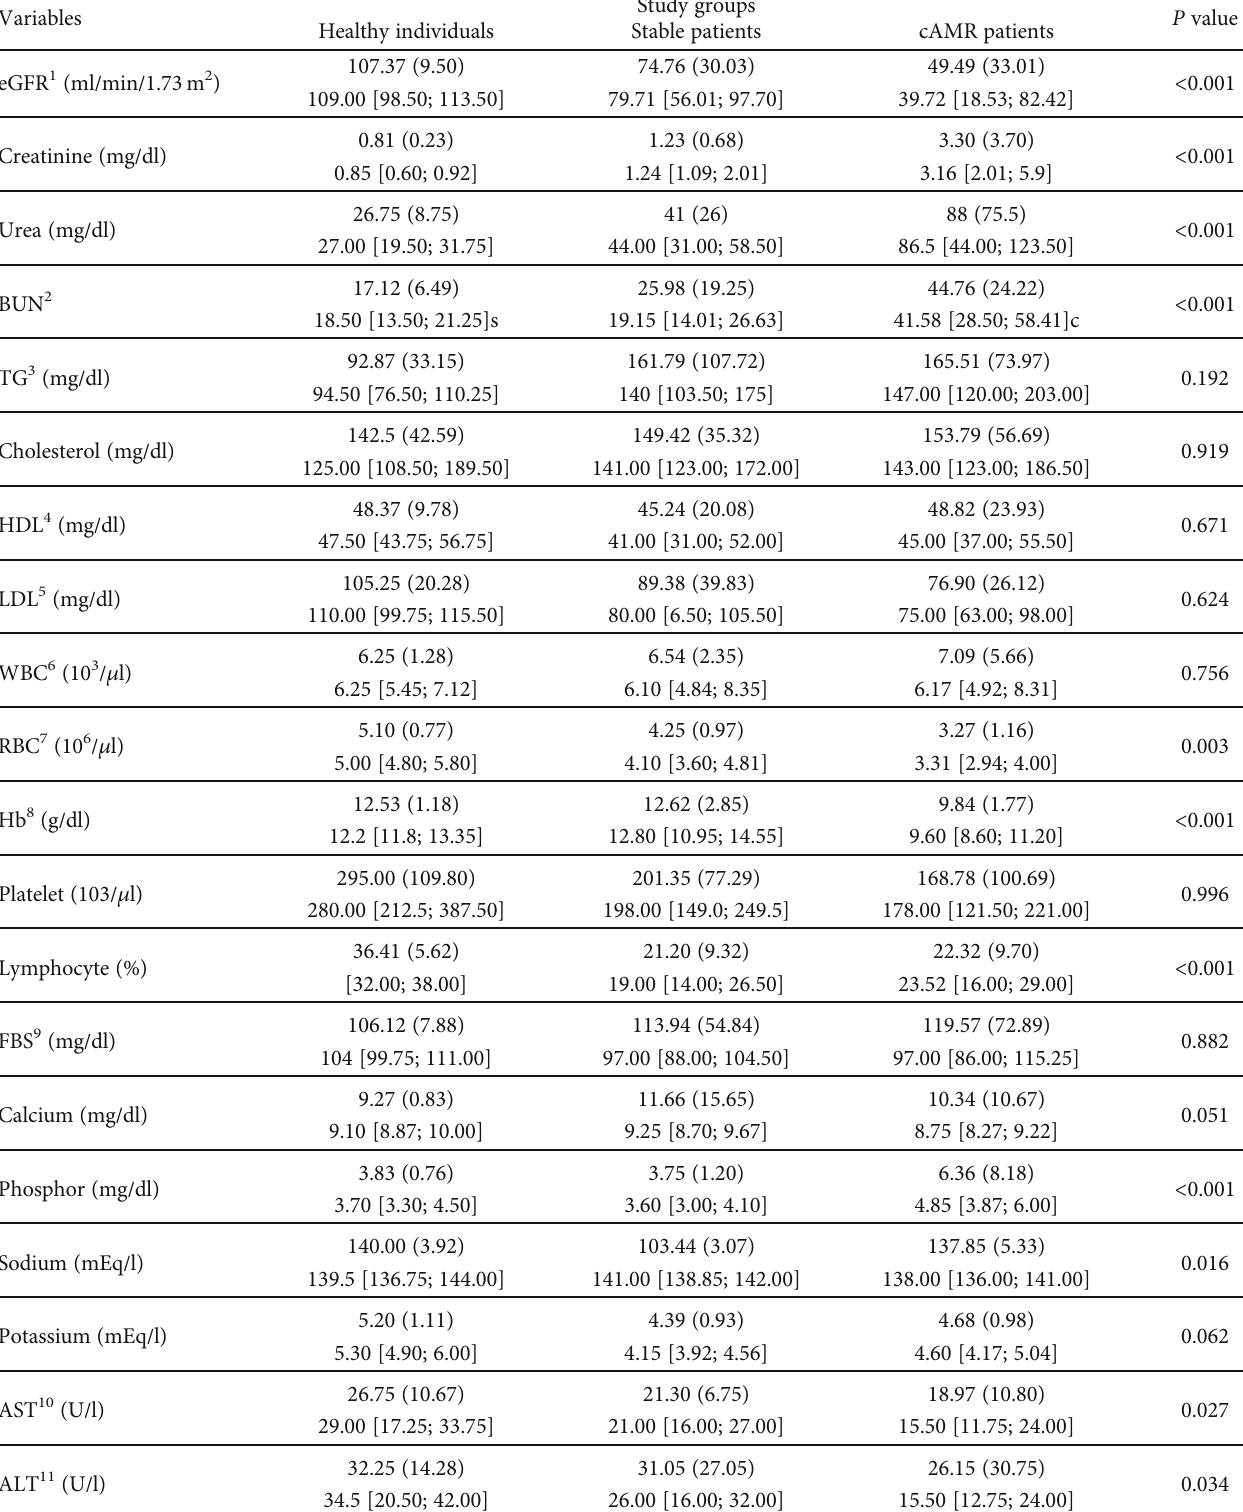
Table 2: Baseline characteristics of study